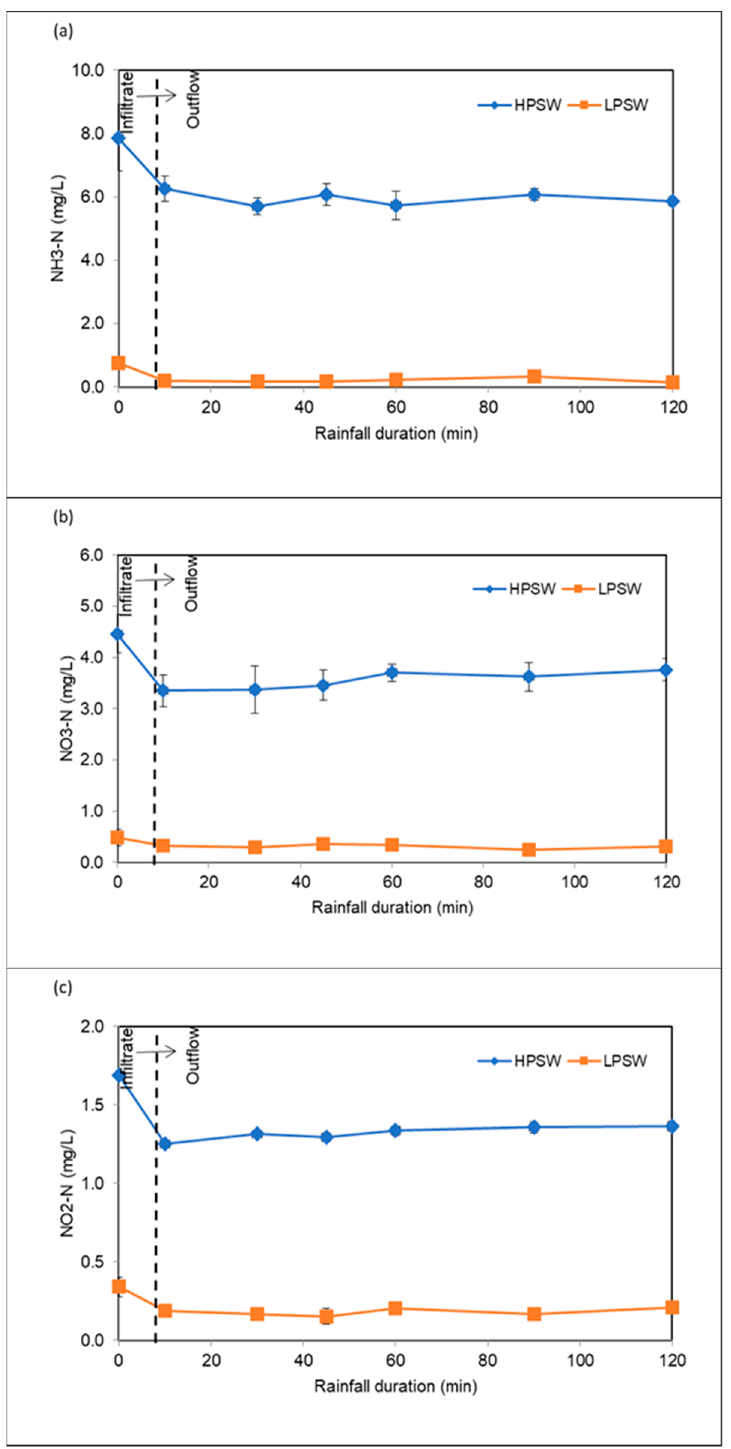
Figure 7. Variations of ( a ) NH 3 –N, ( b ) NO 3 –N, and ( c ) NO 2 –N before and after infiltration through permeable clay bricks.